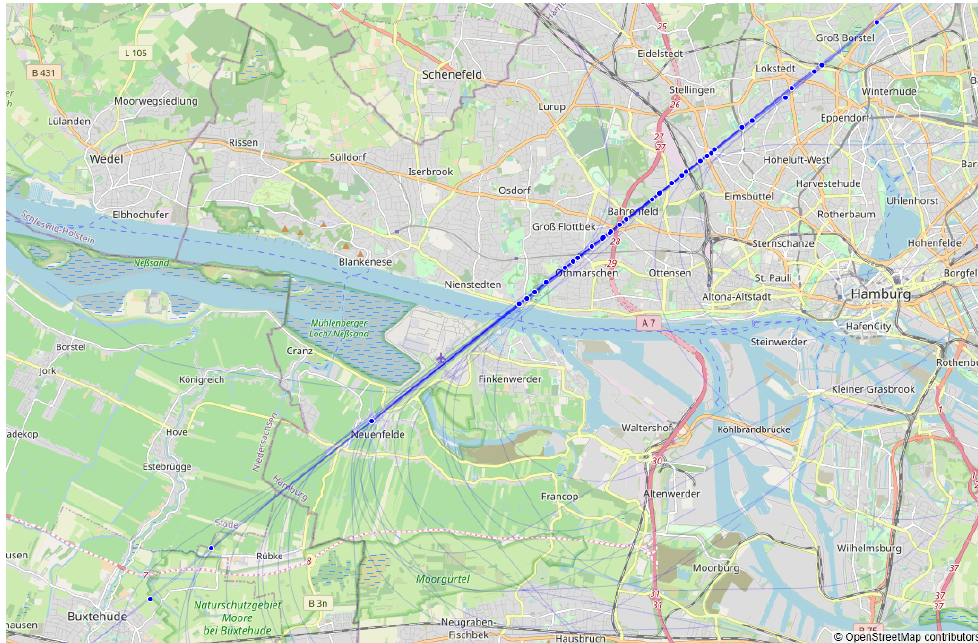
Figure 1. Location of go-around point (blue) for Finkenwerder Airport (runway orientation 05/23 and elevation 23 ft above mean sea level) in